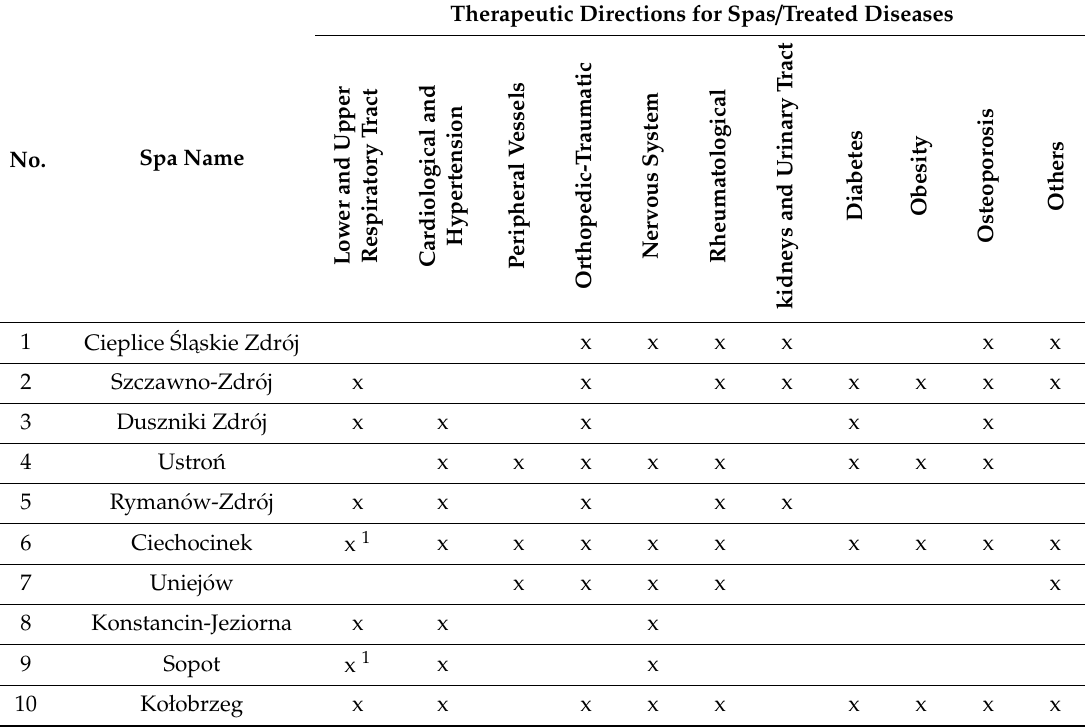
Table 1. Treatment directions for the spas selected for analysis.